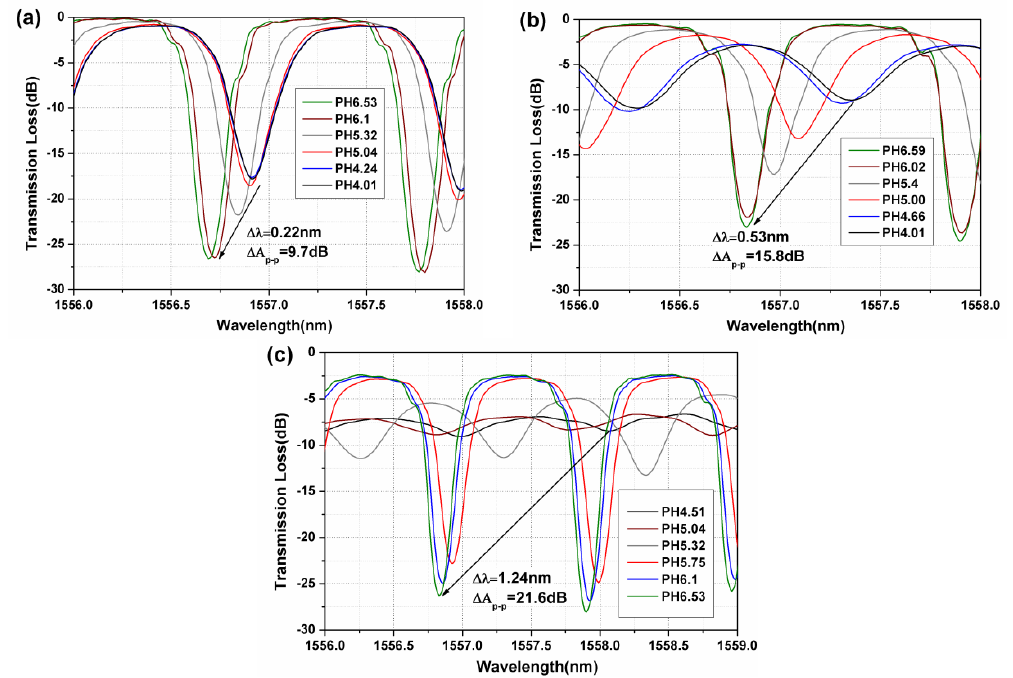
Figure 6. Evolution of optical spectra of TFBG pH sensors with different